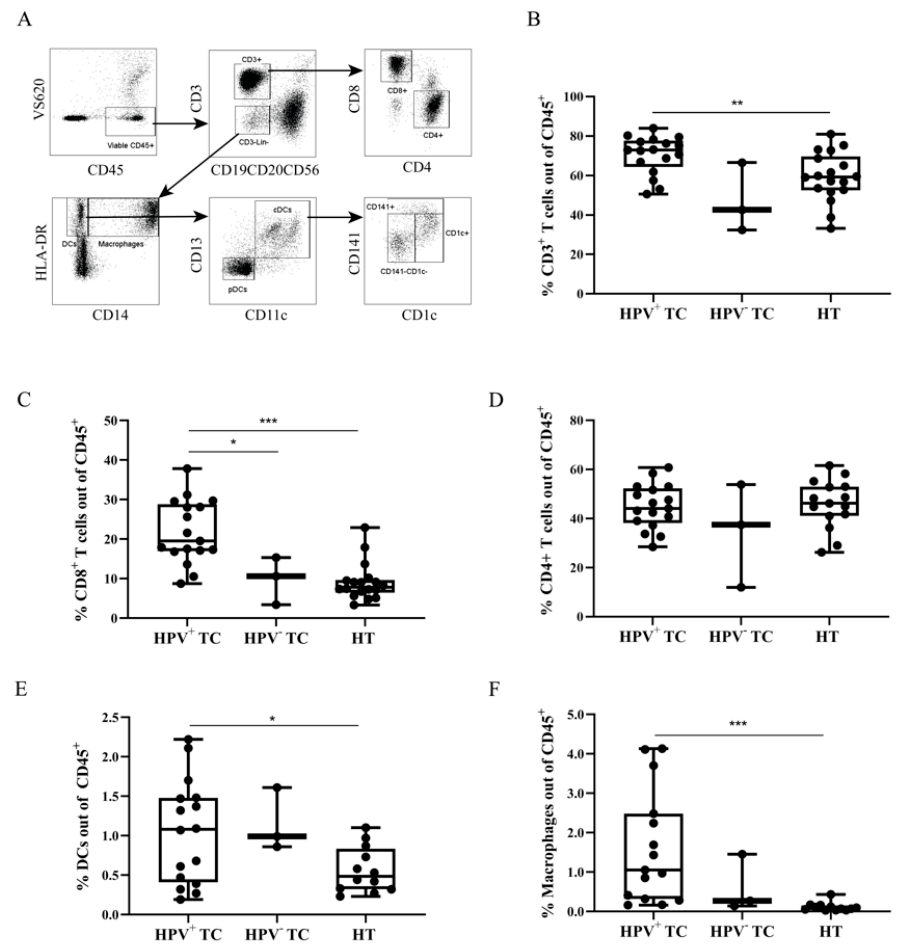
Figure 2. Frequency of infiltrating leukocyte populations in TC and HT. ( A ) Gating strategy: After doublet exclusion on viable cells, leukocytes were gated according to CD45 expression. T-cells were gated as CD3 + Lineage – (Lin; CD19, CD20, and CD56) and subdivided into CD8 + and CD4 + cells. Antigen presenting cells (CD3 – Lin – HLA-DR + ) were divided into CD14 – DCs and CD14 + macrophages. cDCs and pDCs were classified as CD11c + CD13 + and CD11c – CD13 – , respectively. cDCs were further classified as CD141 + , CD1c + , and CD141 − CD1c − . ( B – F ) Box plots comparing frequencies of ( B ) CD3 + T-cells, ( C ) CD8 + T-cells, ( D ) CD4 + T-cells ( E ) DCs, and ( F ) macrophages according to tissue and HPV status. Adjusted p -values are shown as * < 0.05, ** < 0.01, *** < 0.005. Dendritic cell (DC); conventional DC (cDC); plasmacytoid DC (pDC); copy number (CN).